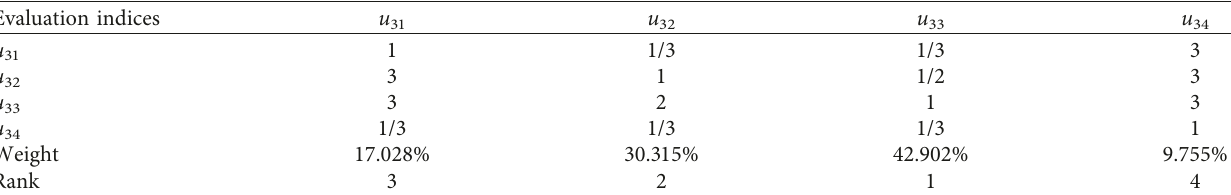
Table 6: Weights and rank of the shield construction.